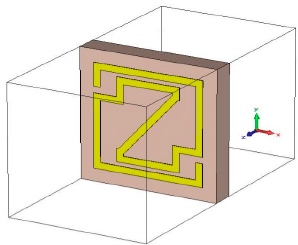
Figure 2. Simulation setup of the proposed Z-shape unit cell for CST Microwave Studio (CST MWS) in a free-space environment.